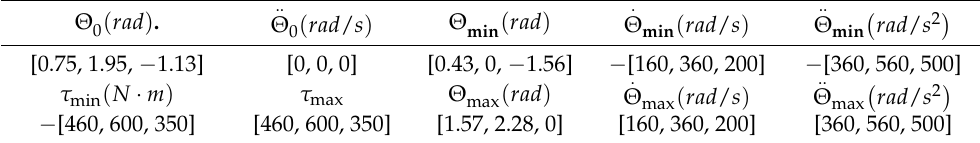
Table 3. The vector in the optimization of trajectory